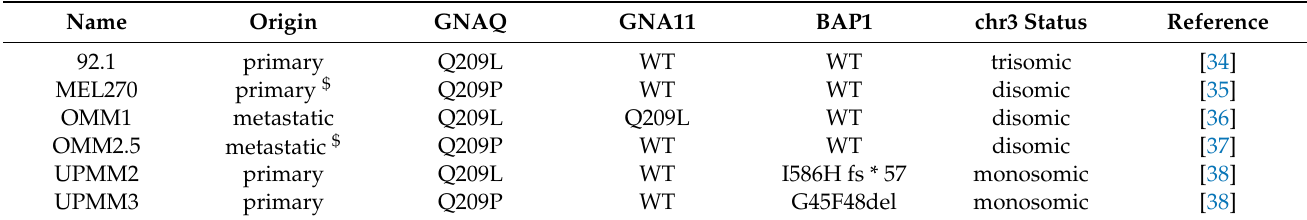
Table 1. Uveal melanoma cell line